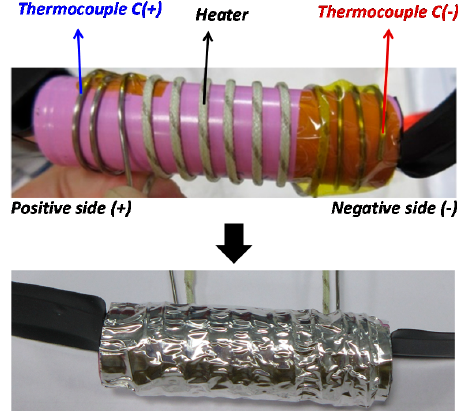
Figure 6. Test sensors (thermocouples C ( + ) and C ( − )) and heater setup on 18650 cells.